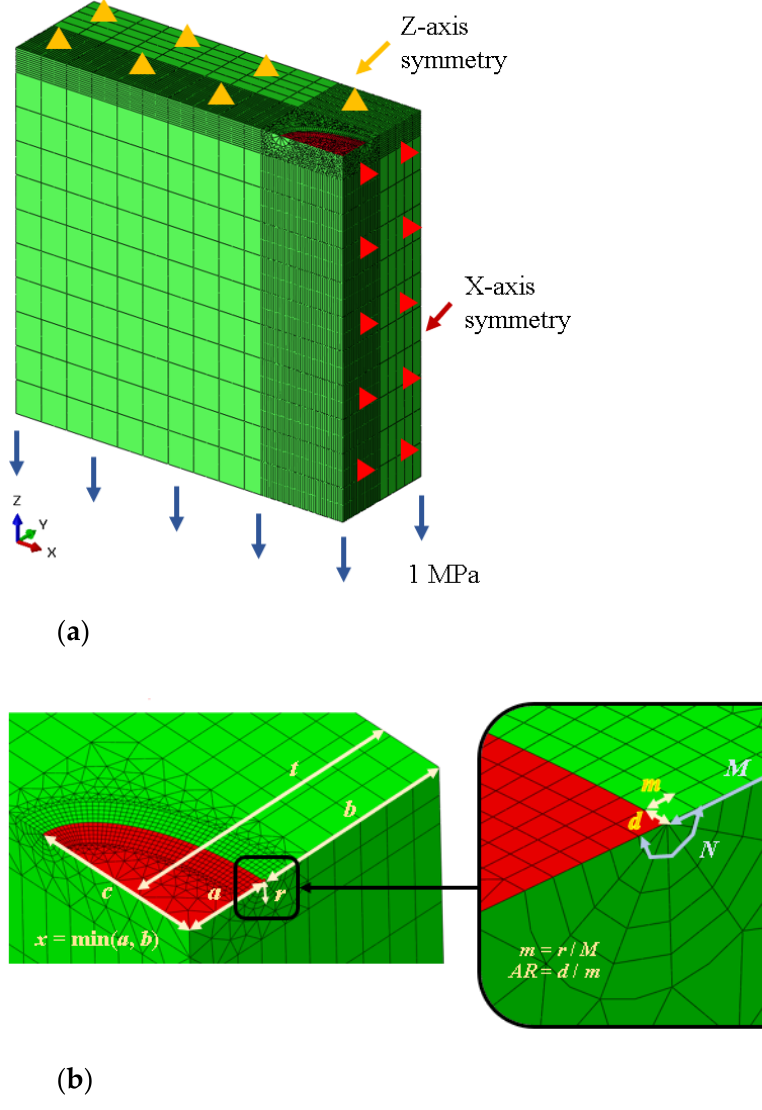
Figure 3. FE model of a flat plate with semi-elliptical crack: ( a ) Boundary and loading condition; ( b ) Detailed crack tip mesh and shape variables.